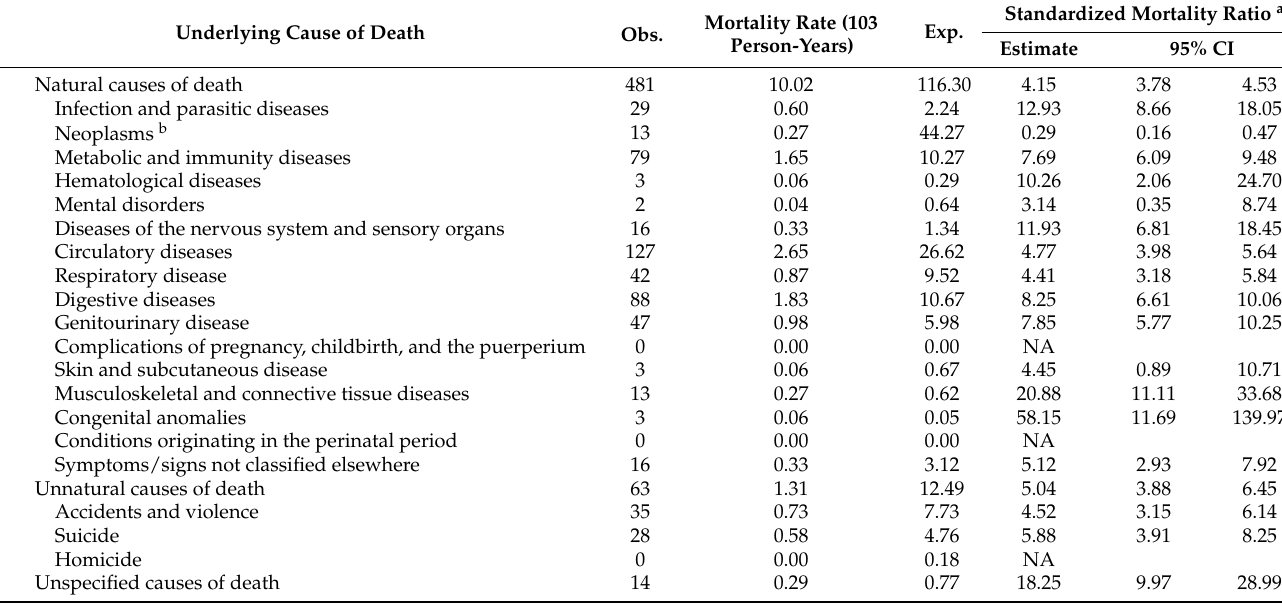
Standardized Mortality Ratio a Mortality Rate (103 Exp. Person-Years) Estimate 95% CI